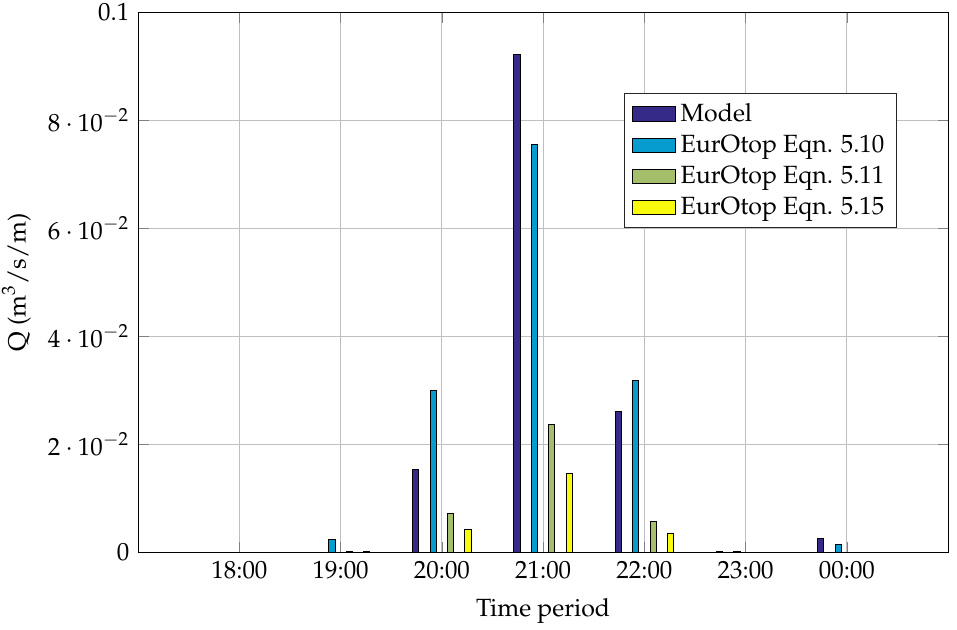
Figure 13. Modelled and estimated overtopping discharge from Equations (5.10), (5.11) and (5.15) from